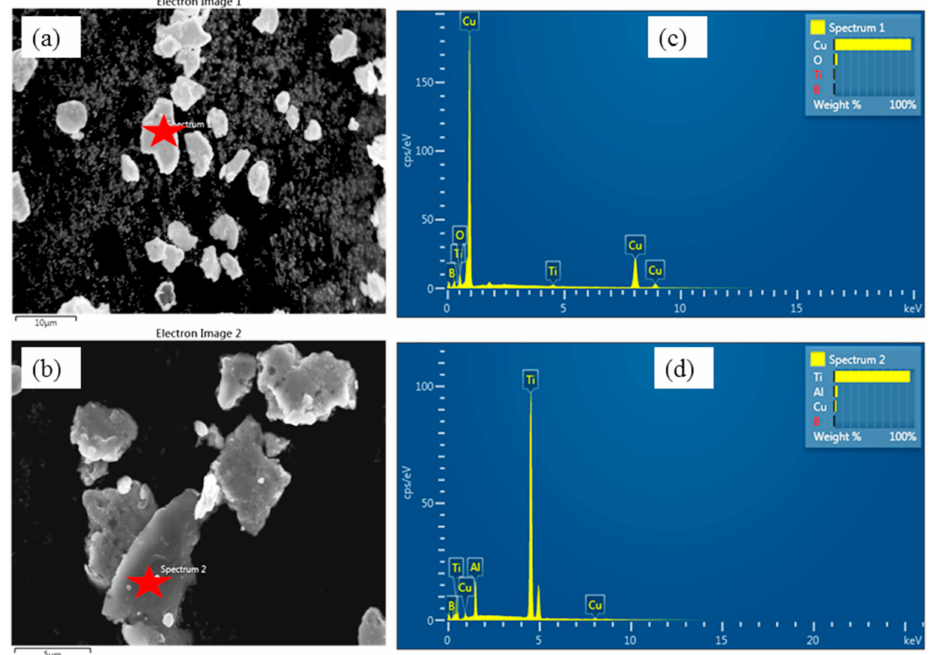
Figure 4. SEM of the two types of ball-milled powder: ( a ) represents Cu-2 wt% B-4 wt% Ti and ( b ) Cu-5 wt% B-10 wt% Ti; ( c , d ) represent corresponding EDX spectra taken on the red star